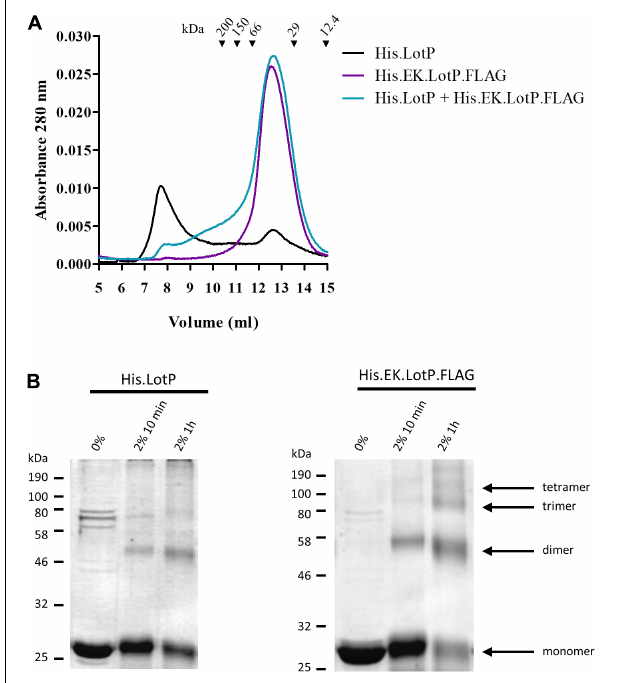
FIGURE 3 | Analysis of LotP multimers. (A) Representative chromatograms of purified His.LotP (black), His.EK.LotP.FLAG (purple), and His.LotP + His.EK.LotP.FLAG (teal) analyzed by size-exclusion chromatography using a Superose 12 column. The purified proteins were separate according to its native molecular size. The elutions were monitored continuously at 280 nm, and the graphic shows the signal at the different elution volumes. (B) Sodium dodecyl sulfate–polyacrylamide gel electrophoresis (SDS-PAGE) of samples of purified His.LotP